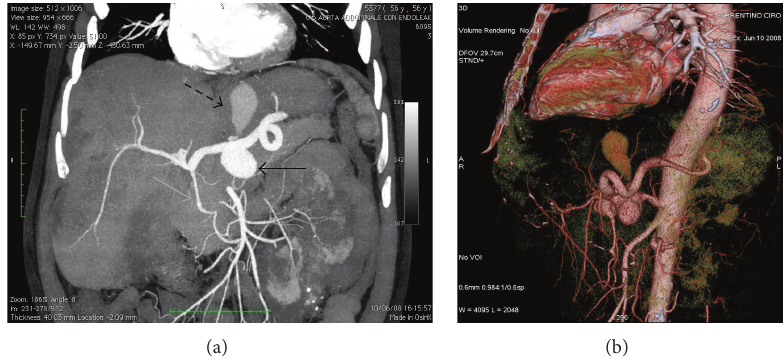
Figure 1: CT scan. (a) Maximum intensity projection (MIP) reconstruction of the arterial phase in the coronal plane showing a 3.8 cm aneurysm of the celiac trunk (solid black arrow) with a 4.3 cm pseudoaneurysm (dashed black arrow) originating from the dissection of the superior margin of the aneurysm sac. An ectasic pancreaticoduodenal arcade is highlighted (grey arrow). (b) Volume rendering (VR) reconstruction in the sagittal plane showing aneurysm and